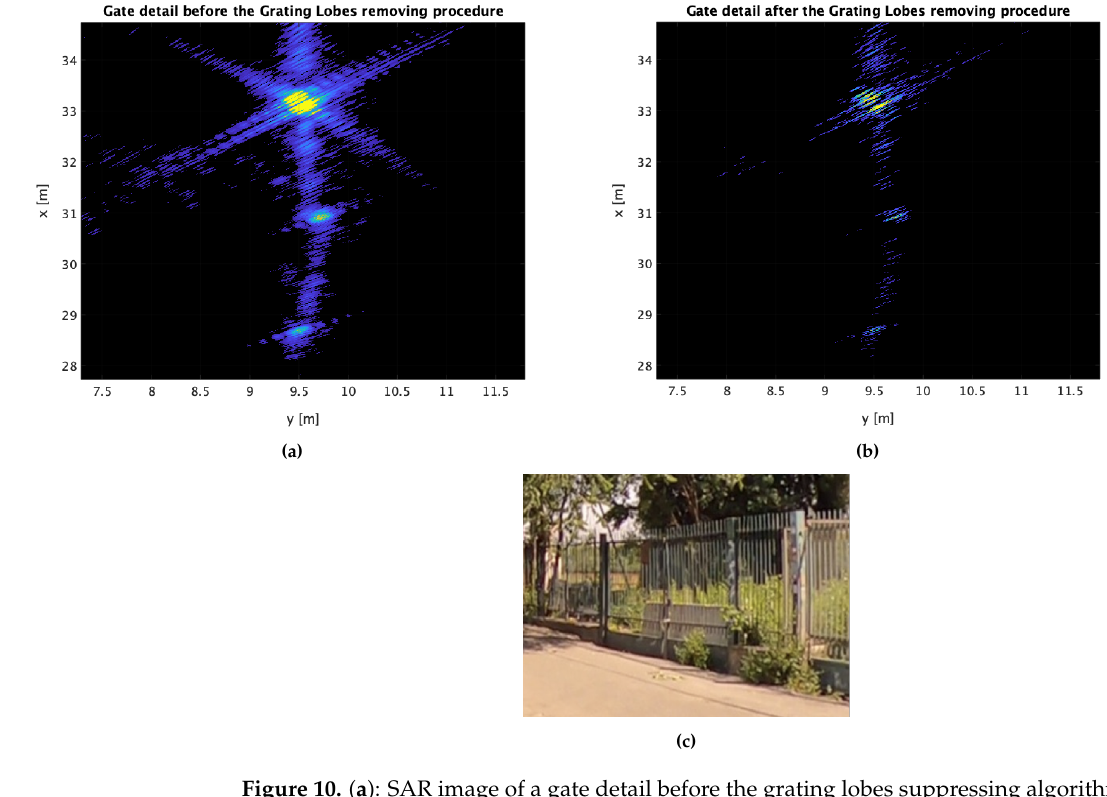
image of a gate detail after the grating lobes suppressing algorithm. ( c ): Optical reference of the detail.